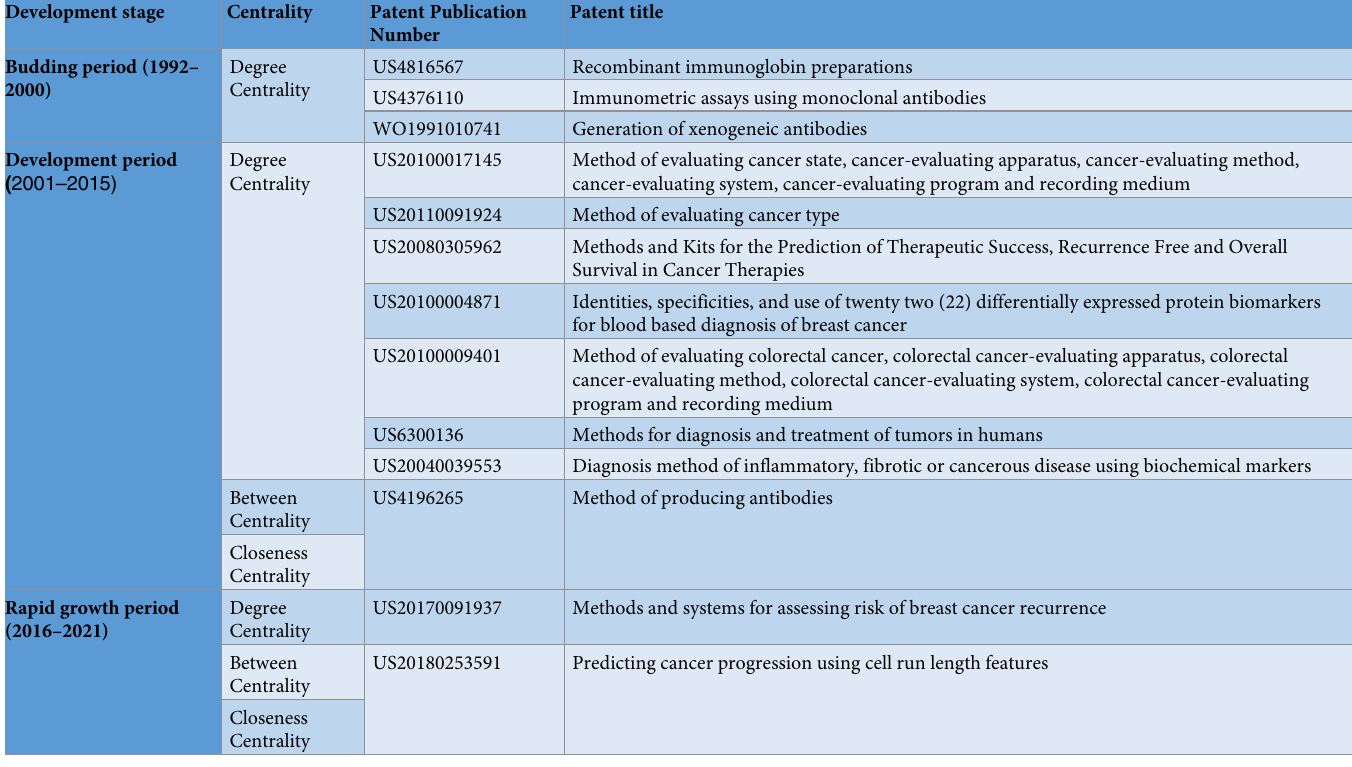
Table 4. The highest centrality patents in each period. Development stage